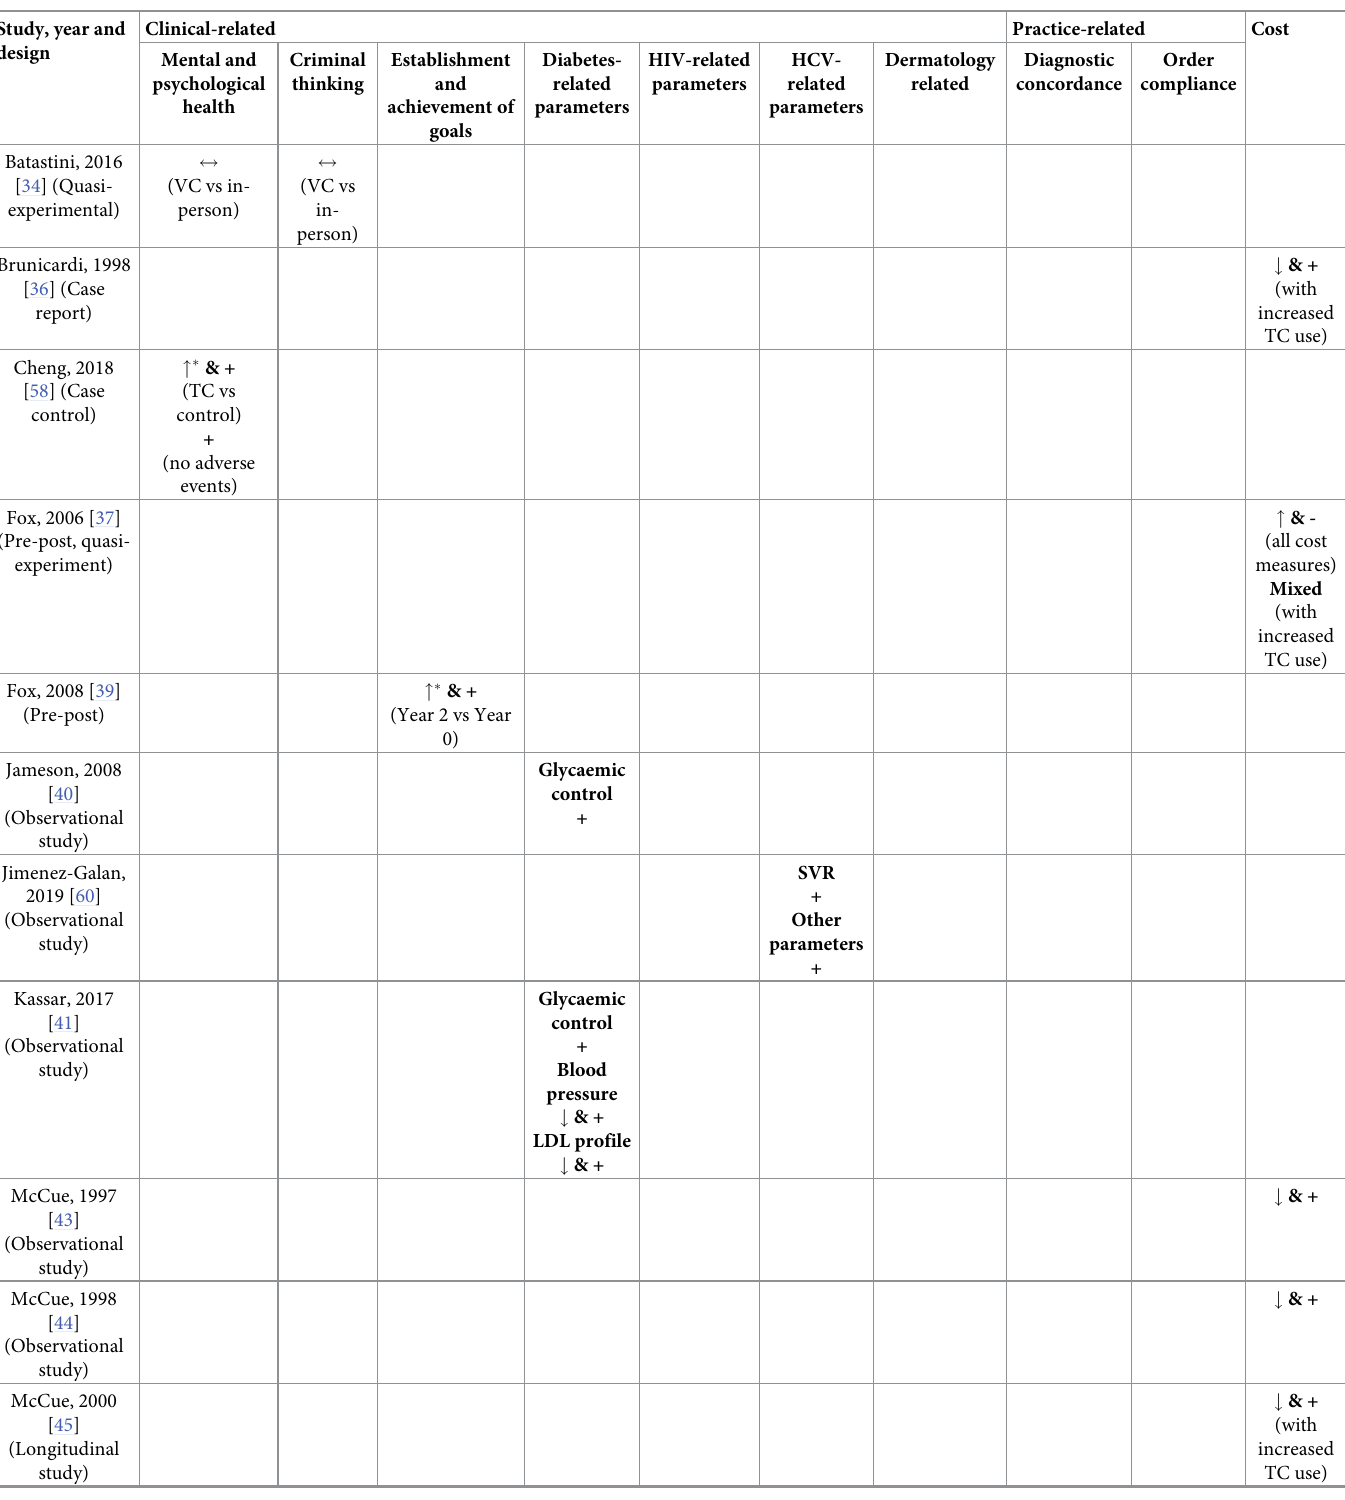
Table 4. Telehealth